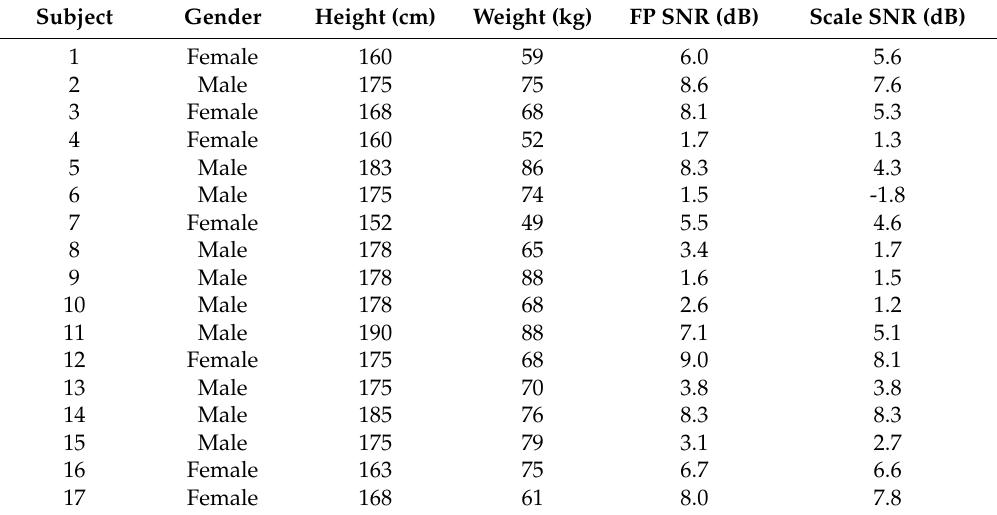
Table 2. Per subject SNR calculations for scale and force plate